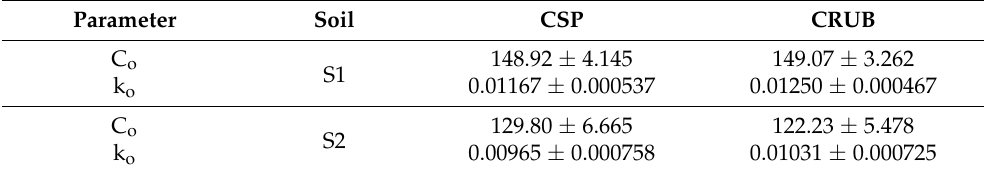
Table 6. Estimated kinetic model parameters for C-CO 2 release in soil and compost. Parameter Soil CSP CRUB C